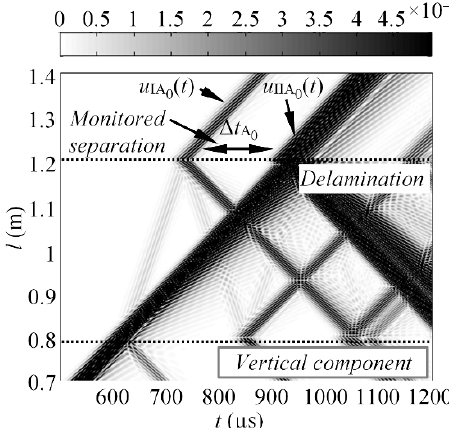
Figure 5. Bscan image of the vertical component of particle velocity, which shows delay between converted and direct A 0 modes beyond the defect.